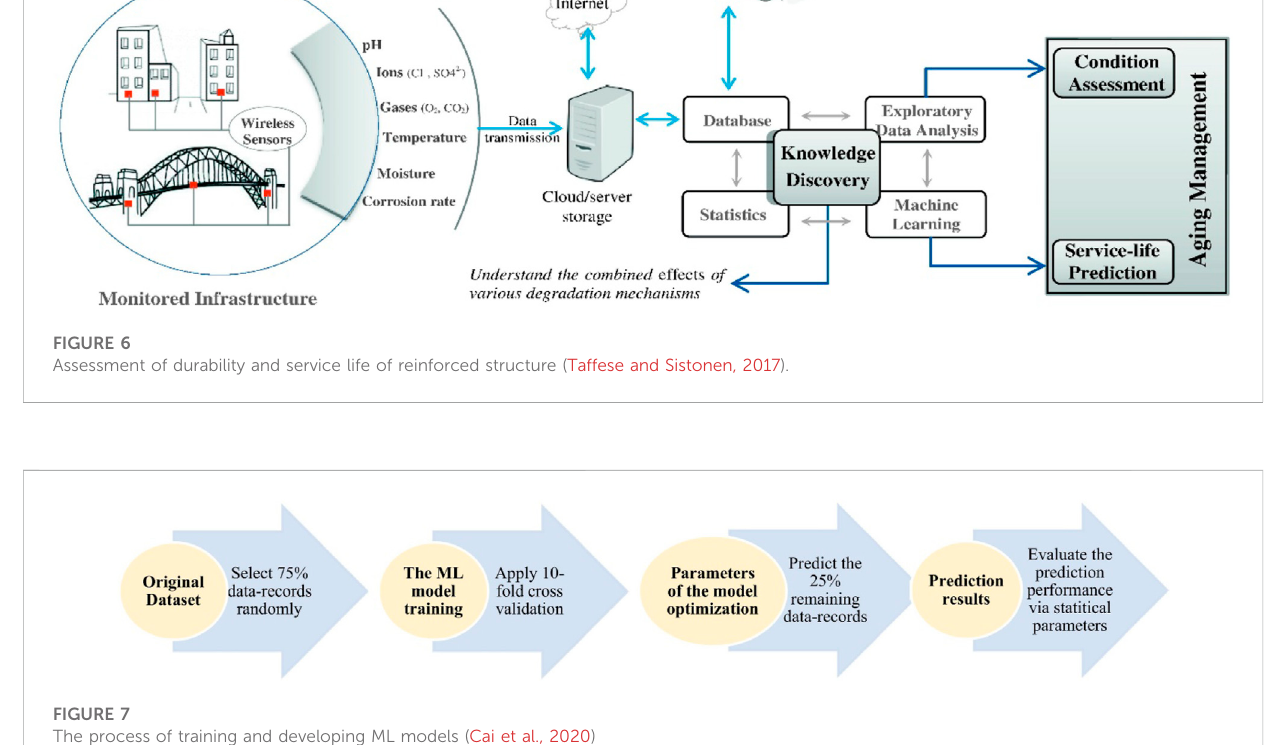
Frontiers in Built